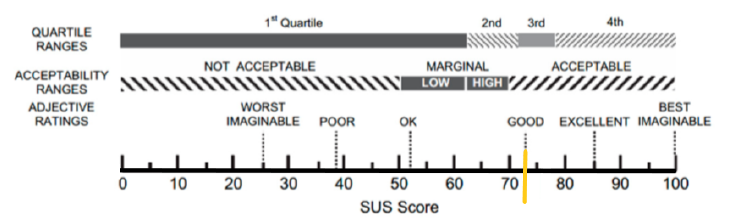
Figure 6. Graphic representation of SUS